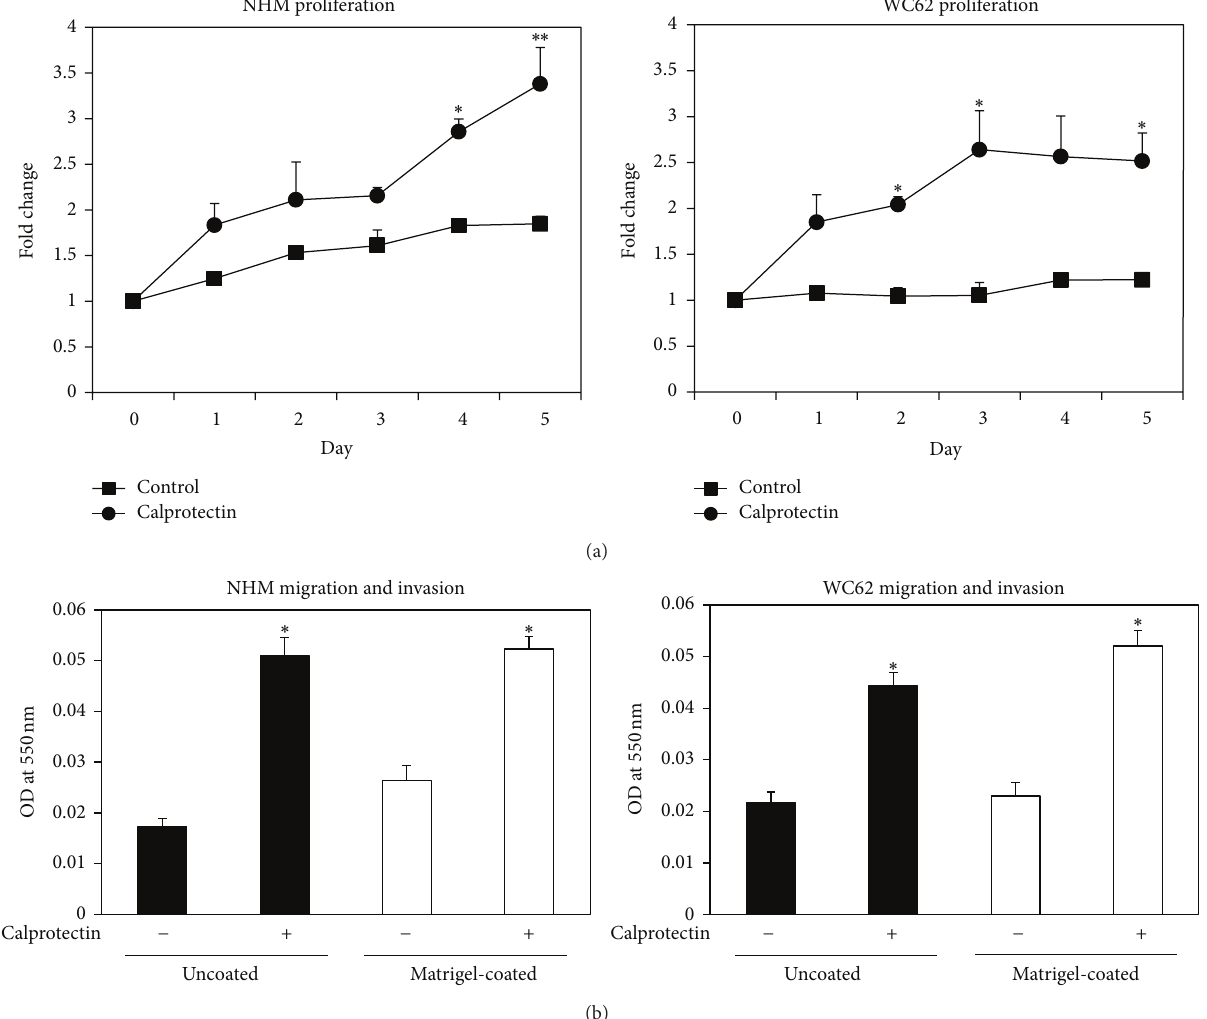
Figure 2: Melanocyte and melanoma cell proliferation and migration in response to calprotectin. (a) NHM or WC62 cells were plated in 96- well plates, treated with a mixture of recombinant S100A8 (100pg/mL) and S100A9 (1ng/mL), and allowed to dimerize in vitro . Cell number was determined using the MTT assay. Triplicate samples were run for each treatment in each experiment and the experiments were repeated 5 times. Bars indicate SEM. Asterisks indicate a significant difference ( 𝑃 < 0.05 ) between control and calprotectin-treated cells as determined by 2-tailed Student 𝑡 -test assuming unequal variance. (b) NHM or WC62 cells were plated in uncoated or Matrigel-coated transwell chambers containing the appropriate growth medium. Lower chambers were filled with medium alone or with medium containing recombinant S100A8 (100pg/mL) and S100A9 (1ng/mL) (Abnova, Taiwan) and were allowed to dimerize in vitro . Twenty-four hours later, the number of cells that had migrated through the membrane was determined as described in the text. Three replicate experiments were performed. Bars indicate SD. Asterisks indicate a significant difference ( 𝑃 < 0.05 ) between control and calprotectin-treated cells as determined by 2-tailed Student 𝑡 -test assuming unequal